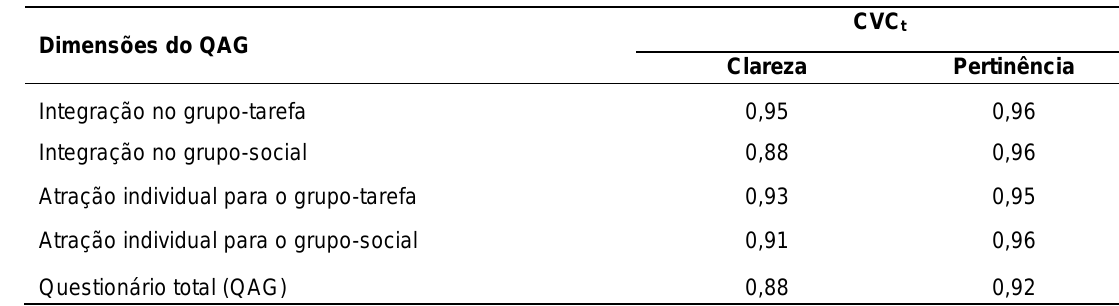
Tabela 1. Coeficientes de validade de conteúdo para os critérios clareza de linguagem e pertinência prática na validação da versão brasileira do Group Environment Questionnaire